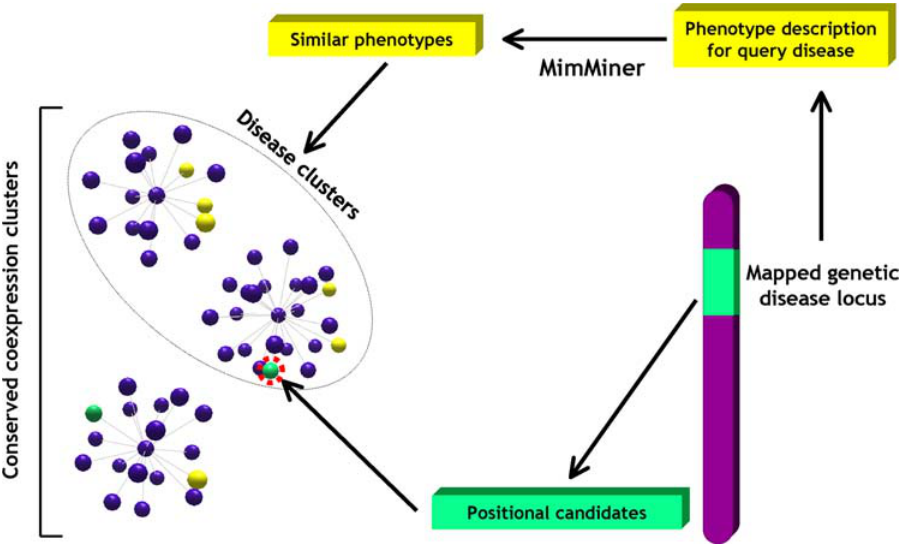
Figure 1. Identification of candidate disease genes by means of conserved co-expression clusters. A locus with positional candidates (green bar) associated with a disease of unknown molecular basis (yellow) is screened for one or more candidate genes (green sphere) that appear in a conserved coexpression cluster (purple spheres) together with at least two other genes known to be involved in similar phenotypes (yellow spheres), as defined by the MimMiner similarity score.